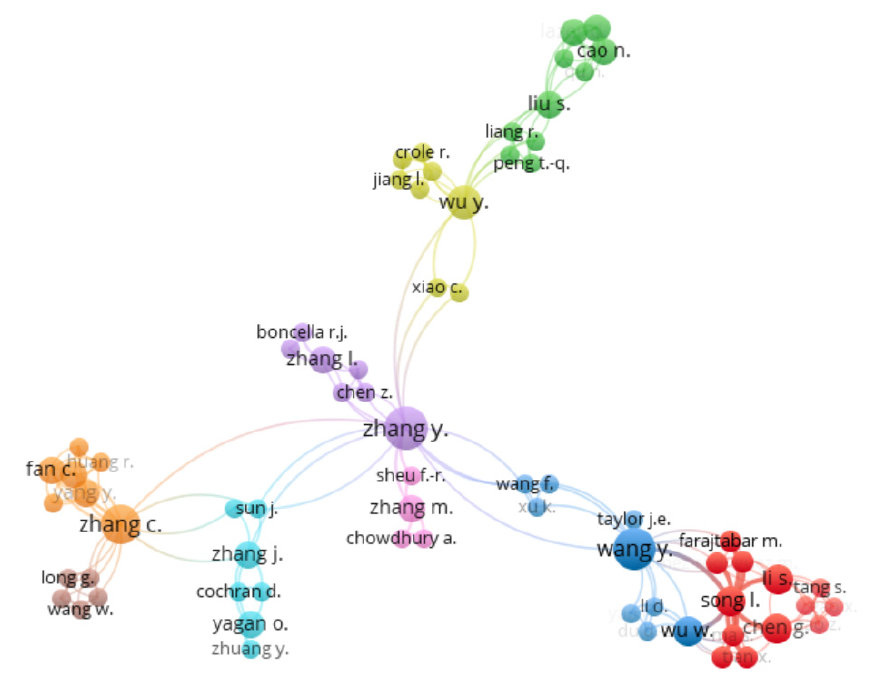
Figure 2. Network visualization of the co-authorship–author relation for Dataset 1.